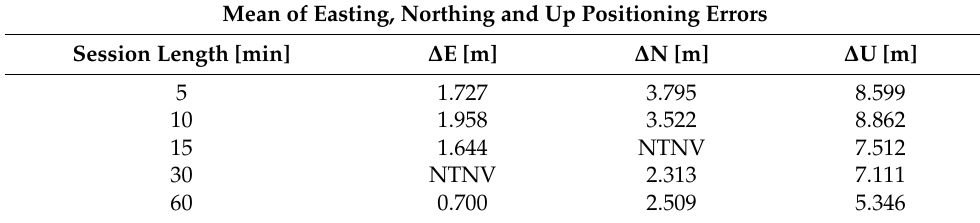
Table 10. Mean of Easting, Northing and Up SPP errors for ∆ E, ∆ N, ∆ U. Mean of Easting, Northing and Up Positioning